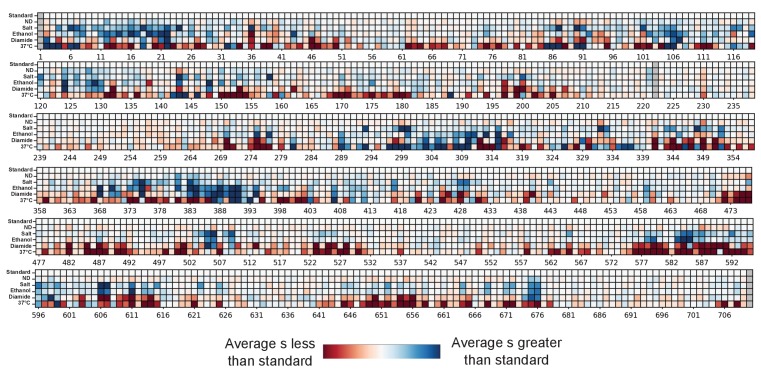
Heatmap representation of the average selection coefficient (s) at each position in each environmental condition relative to the average selection coefficient at the same position in standard conditions.